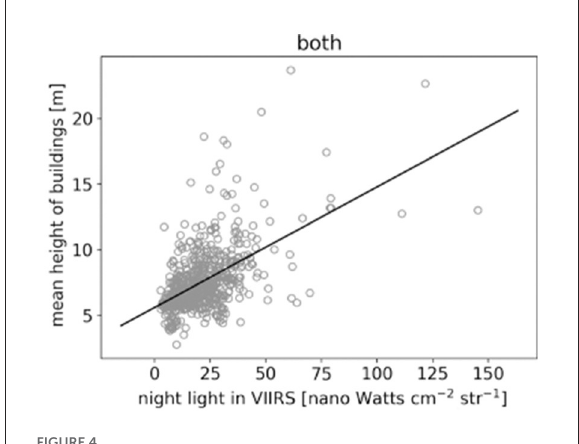
FIGURE4 Scatter plot of the night light and building height for land use ratio of 80% and above.